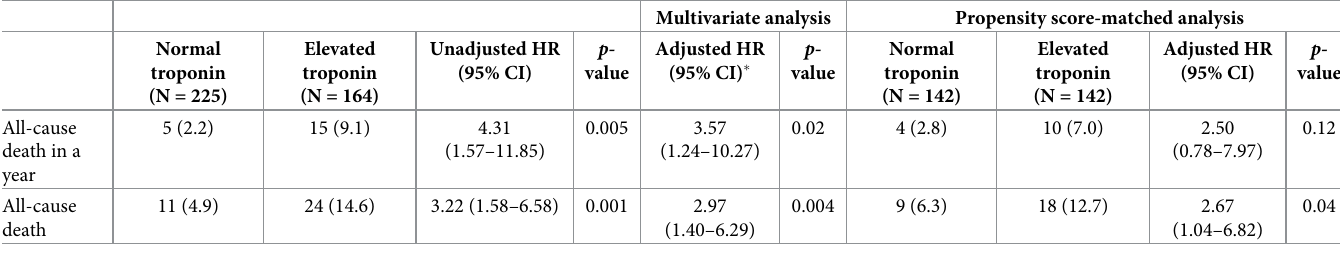
Table 2. All-cause death in the entire and propensity-matched populations.